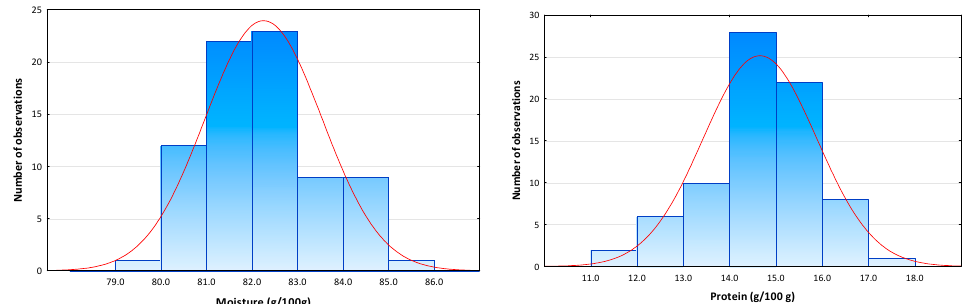
Figure 2. Histograms of moisture and protein content distribution in control Octopus vulgaris samples (n = 77) with fitted normal curve.